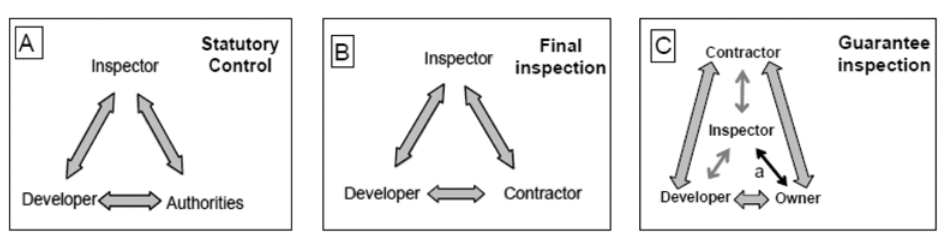
Relationships during building inspection (source: